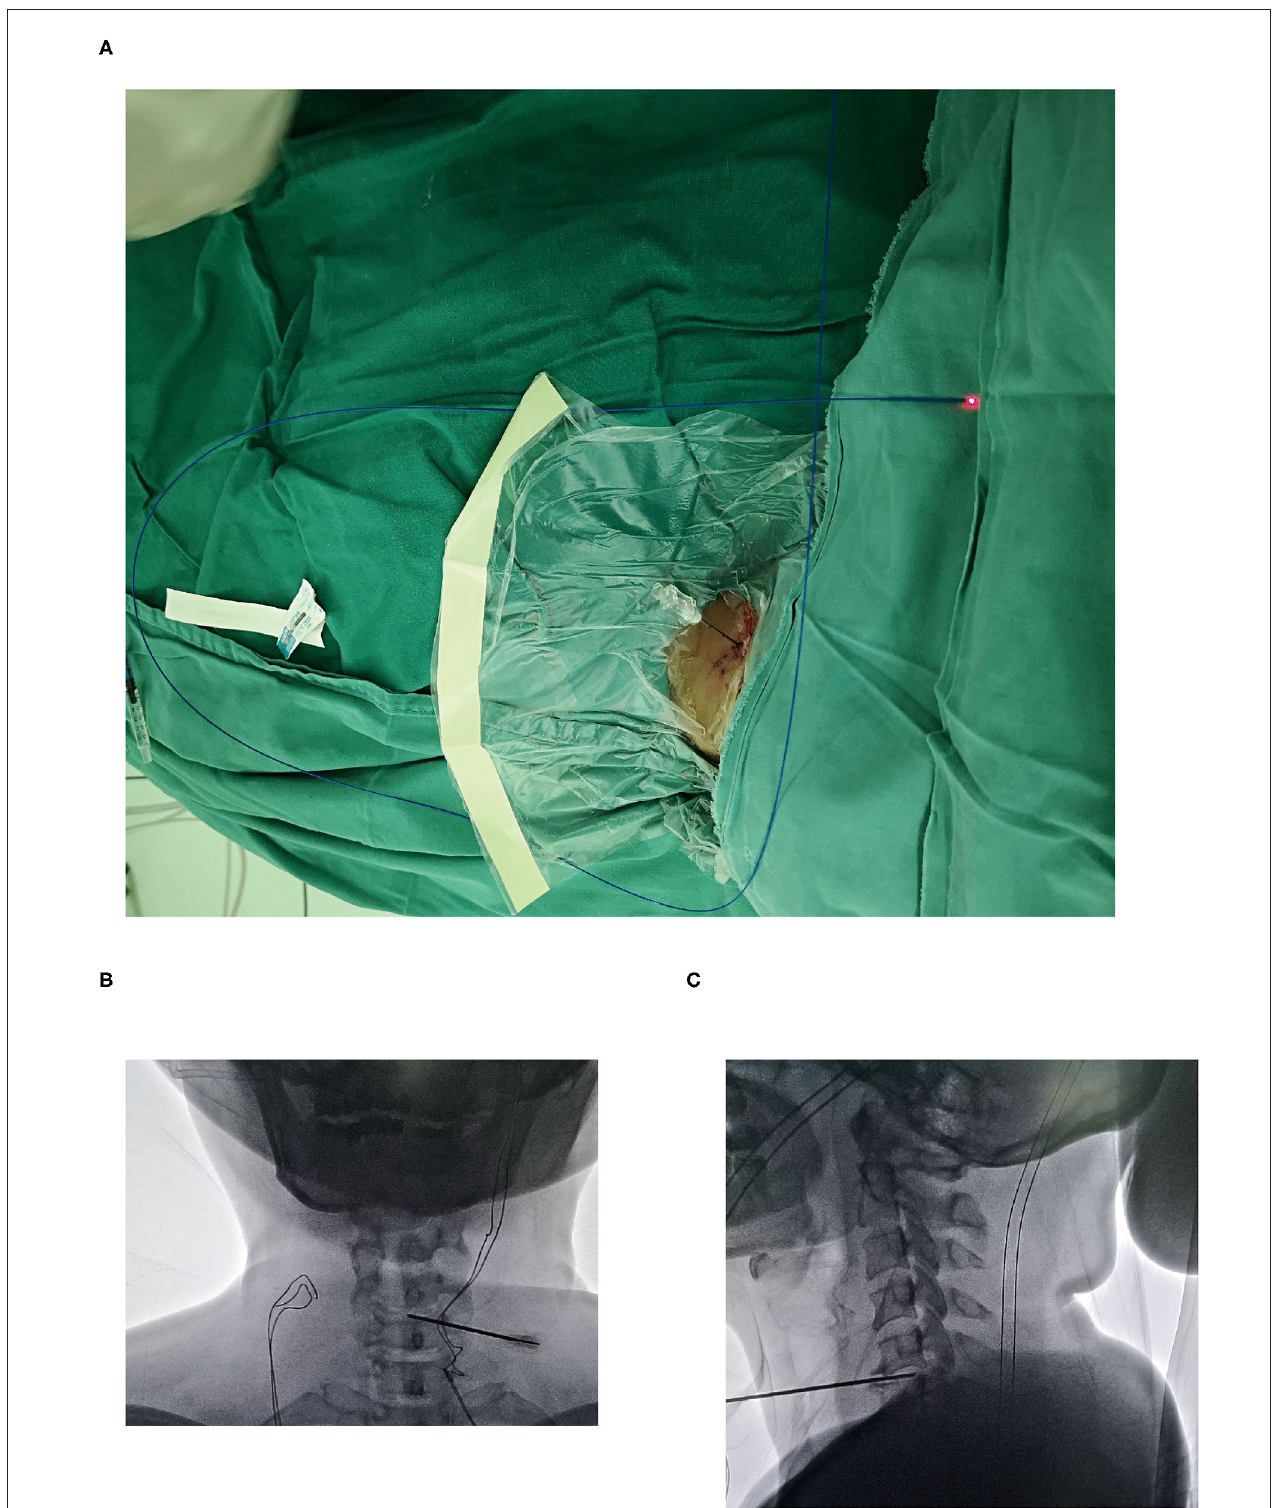
FIGURE 2 | Placement of cannula during minimally invasive procedures. (A) Introducing cannula inserted in a 30 degrees angle medially with radiological guidance. Cannula position was confirmed by the (B) anterior-posterior and (C) lateral view.